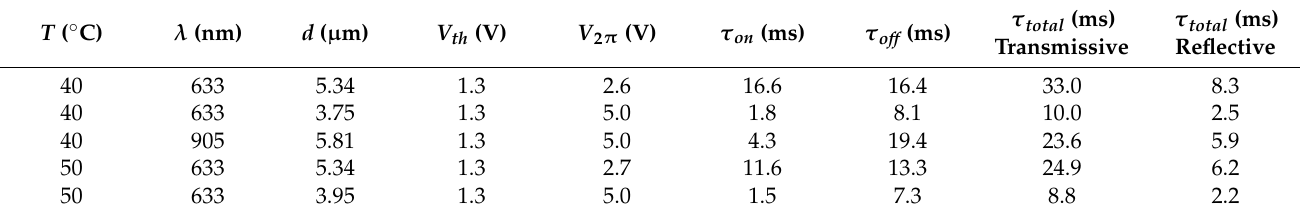
Table 3. Measured response time of a transmissive A4907 with d = 5.34 μ m, and the extrapolated response time to the corresponding reflective cells at 40 °C ( λ = 633 nm and λ = 905 nm) and 50 °C ( λ = 633 nm).